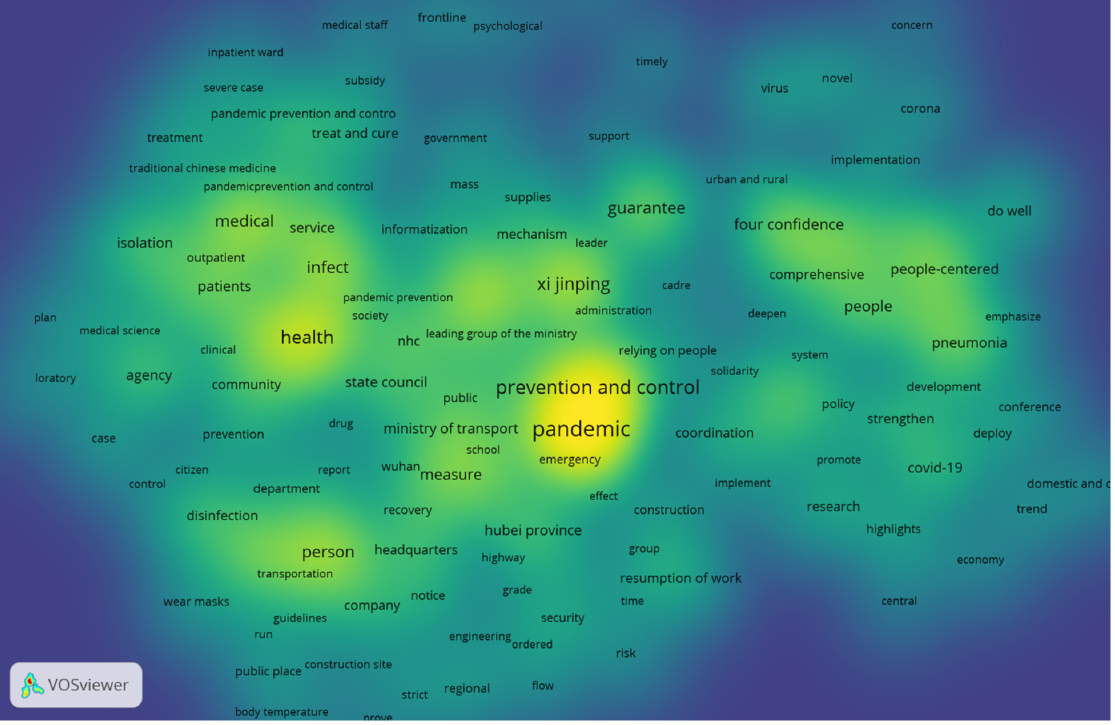
Figure 5. Density visualization of Chinese COVID-19 pandemic prevention and control policies. Source: Generated by the authors.